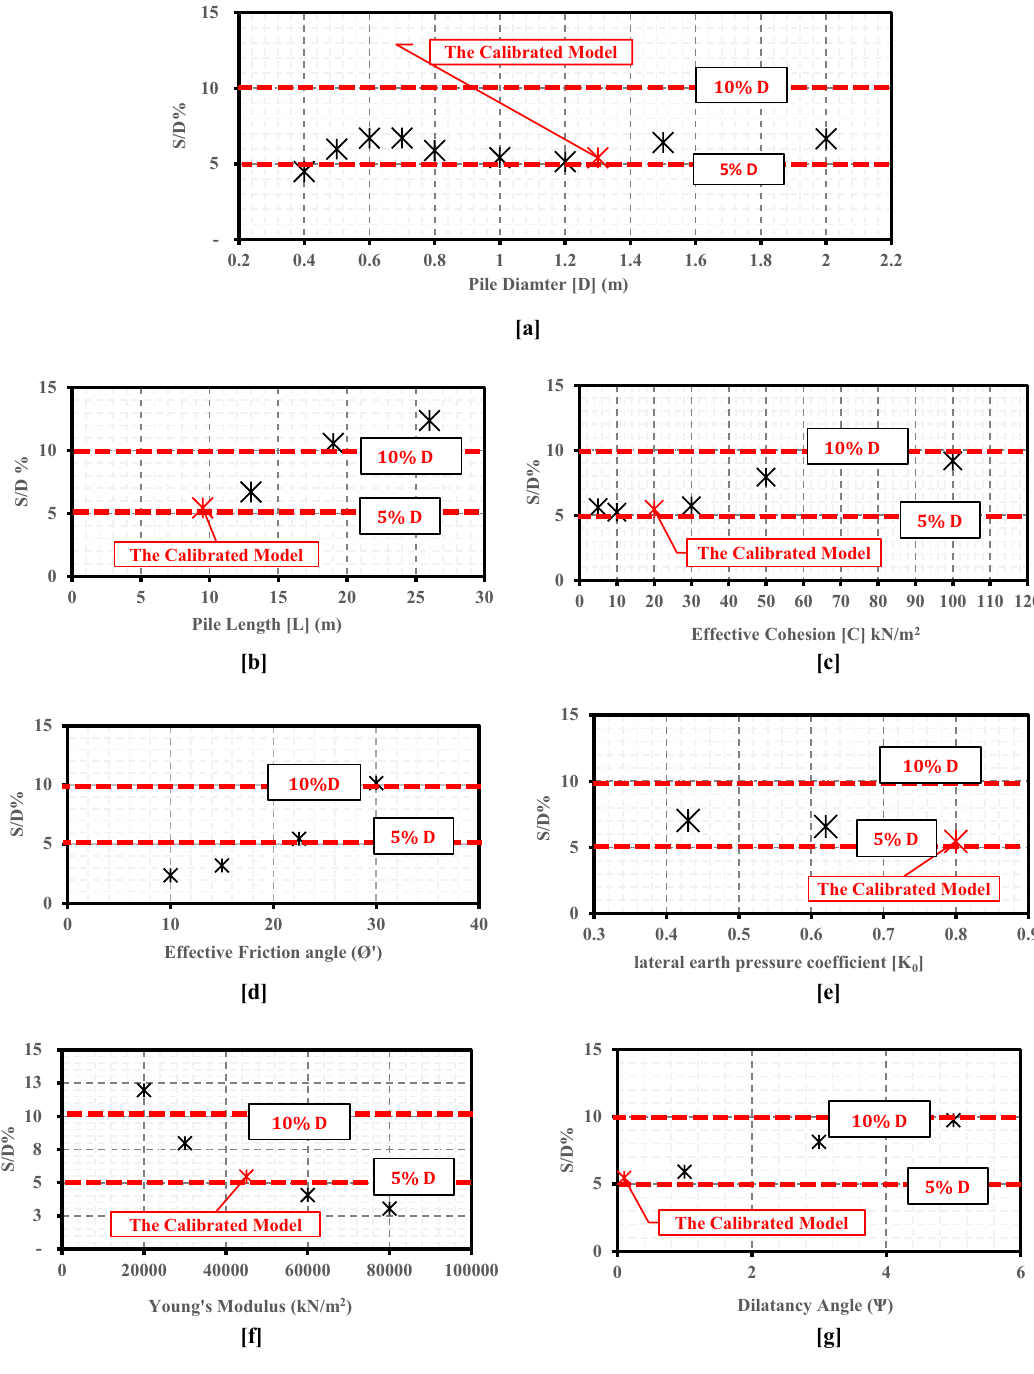
Figure 7. Variation in the pile’s settlement to diameter percentage (S/D%) due to the change in different parameters. ( a ) Pile diameter (D). ( b ) Pile length (L). ( c ) Soil effective cohesion (c ′ ). ( d ) Soil effective friction angle (Ø ′ ). ( e ) Soil lateral earth pressure coefficient (k 0 ). ( f ) Soil Young’s modulus (E s ). ( g ) Soil dilatancy angle ( Ѱ